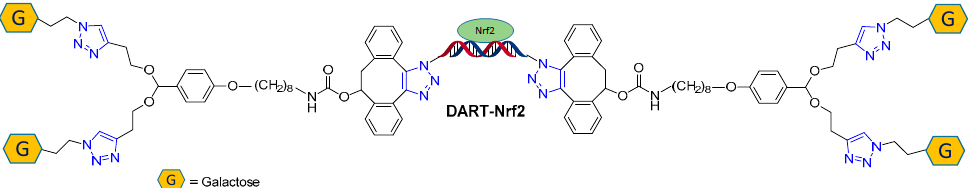
Figure 4. DART-Nrf2 multifunctional oligonucleotide.